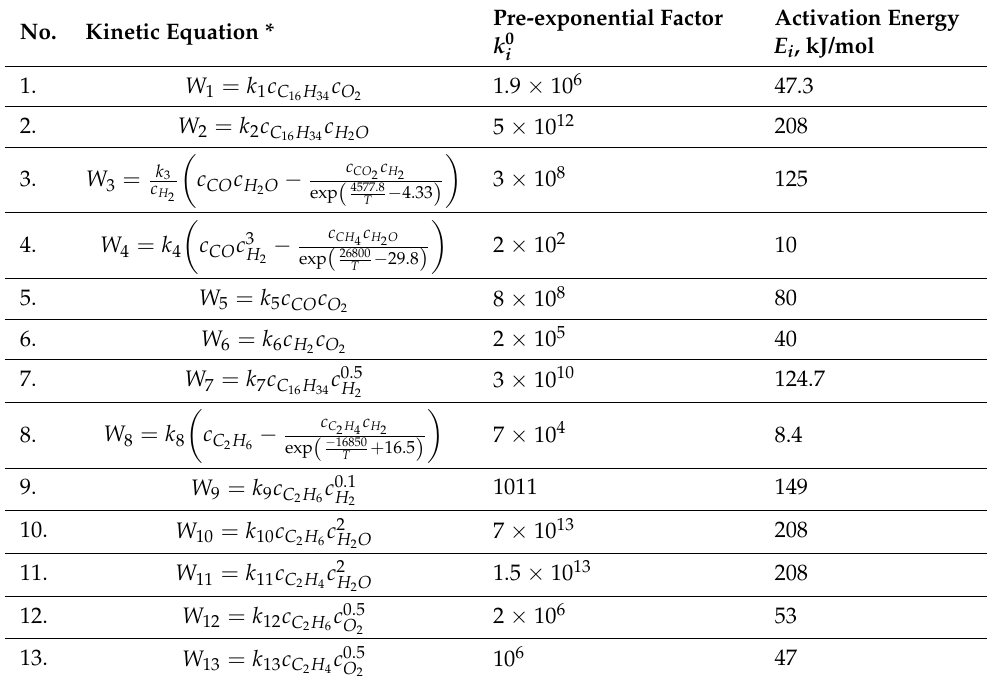
Table 3. The optimum kinetic equations and kinetic parameters of Reactions (4)–(6) [95].